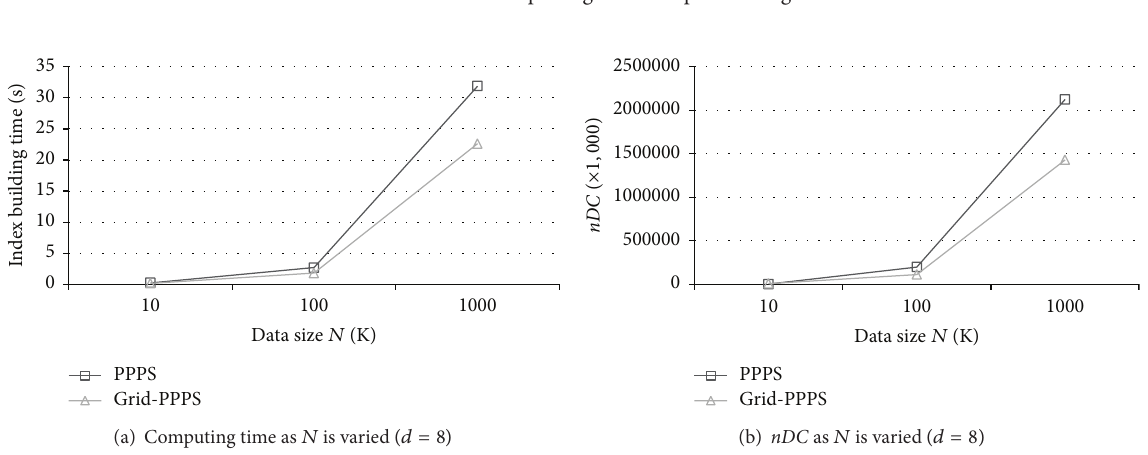
Figure 3: The example of grid-based partitioning.